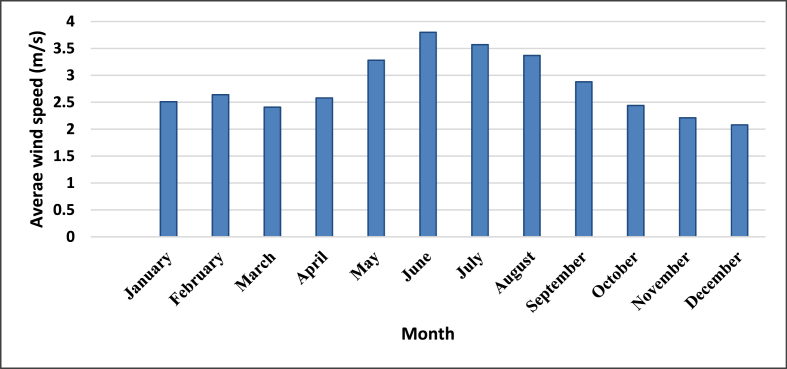
Wind energy profile.